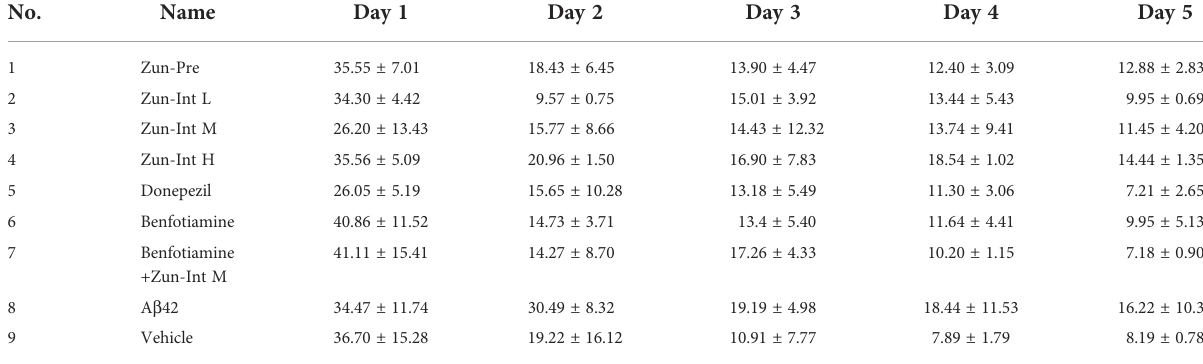
TABLE 3 Escape latency of mice in each